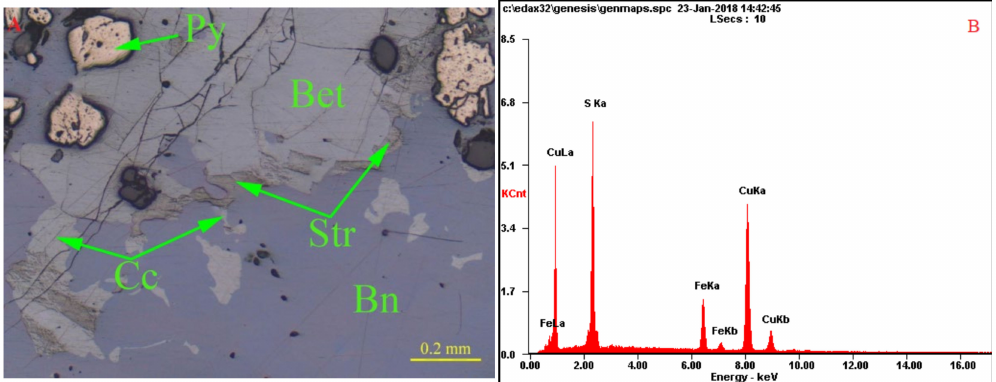
Figure 3. Images and EDS analysis of bornite (Py = pyrite, Bet = Betekhtinite, Cc = Chalcocite, Str = Stromeyerite, Bn = bornite); ( A ) represents the microscope image of the valuable mineral; ( B ) represents the EDS analysis of bornite.